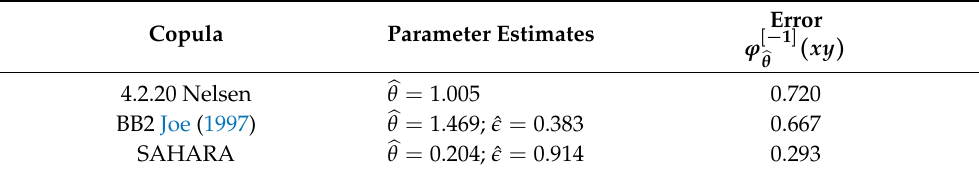
Table 1. Results for several copula